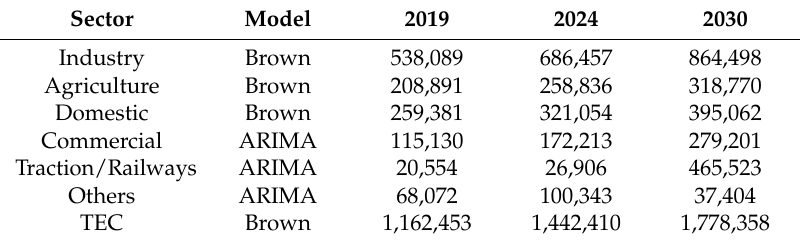
Table 11. Summary of the results and Time line forecasted values for